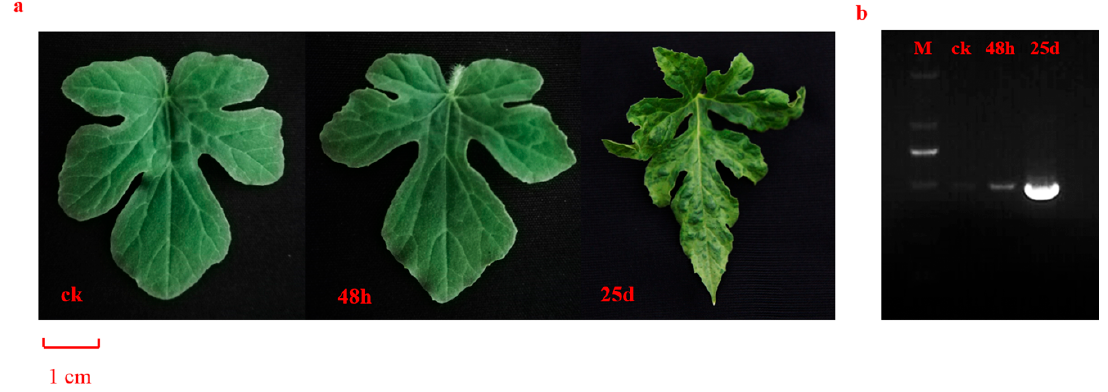
Figure 1. Phenotypes and verification of watermelon leaves before and post Cucumber green mottle mosaic virus (CGMMV) infection. ( a ) Phenotypes of watermelon leaves before and after CGMMV infection. Leaves from left to right were ck (control), 48 h, and 25 d post CGMMV infection, respectively. The scale bar is 1 cm for the watermelon leaves. ( b ) RT-PCR analysis of CGMMV presence for ck, 48 hpi (hours post-inoculation), and 25 dpi (days post-inoculation). Lanes from left to right were DL2000 marker, fragments of ck, 48 hpi, and 25 dpi, respectively.